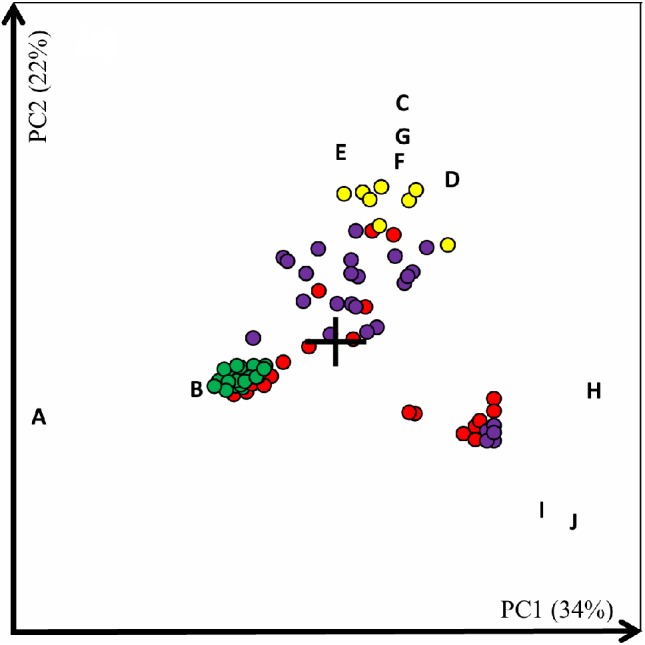
PC-plot of all samples based on variables comprising bacterial taxa.2D PC-plot. Each circle represents one sample. Green, combined visceral samples including stomach, pyloric caeca, midgut and hindgut. Red, abdominal cavities. Violet, skin mucus. Yellow, storage ice. The first and second principal components (PC1 and PC2) describe 34% and 22%, respectively, of the total variance. The ten most discriminatory variables are illustrated. A, Mycoplasmataceae (f), B, Aliivibrio (g), C, Moraxellaceae (f), D, Acinetobacter (g), E, Psychrobacter (g), F, Flavobacterium (g), G, Chryseobacterium (g), H, Janthinobacterium (g), I, Elizabethkingia (g) and J, Enterobacteriaceae (f). f, family, g, genus.